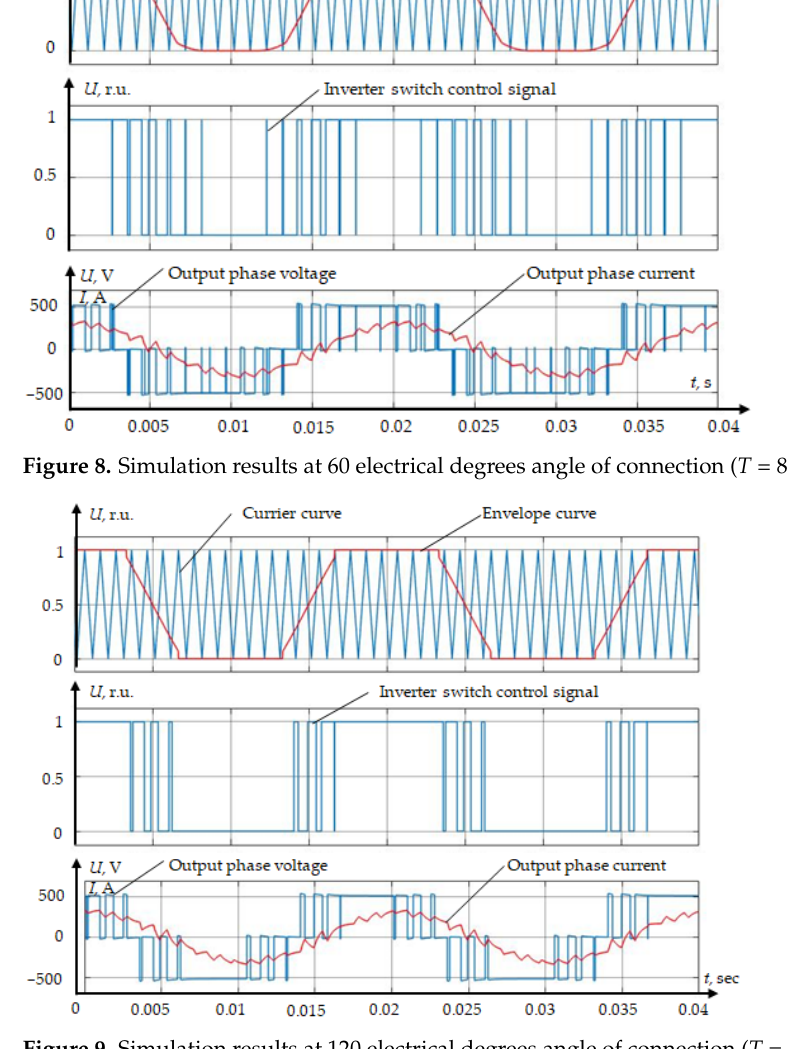
Figure 9. Simulation results at 120 electrical degrees angle of connection ( T = 100 ◦ C).